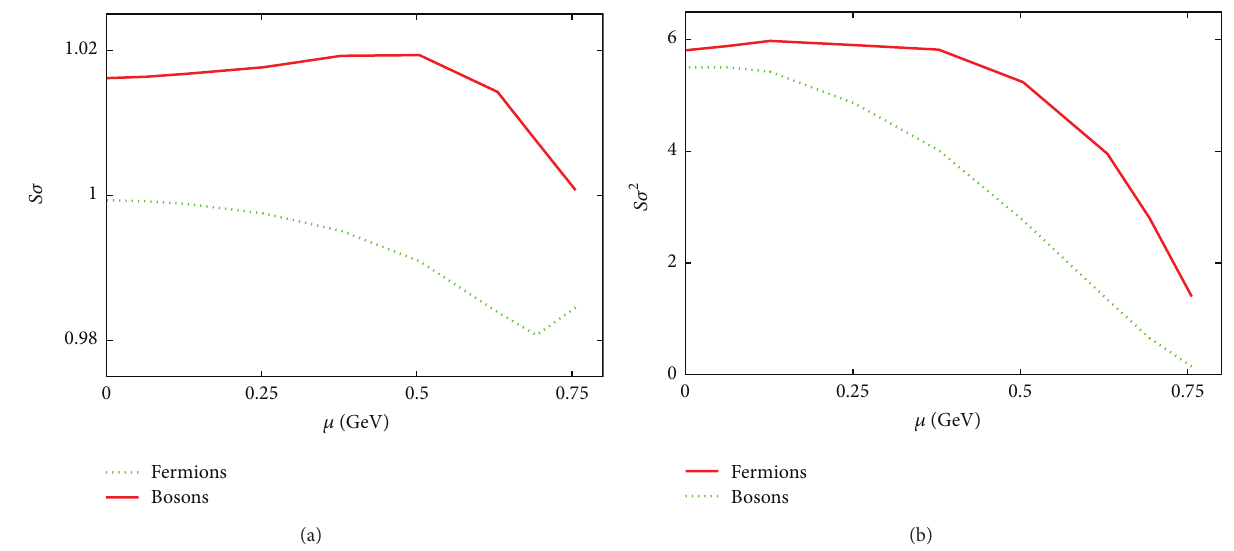
Figure 11: The dependence of 𝑆𝜎 (a) and 𝑆𝜎 2 (b) of bosons and fermions on the chemical potential 𝜇 (given in